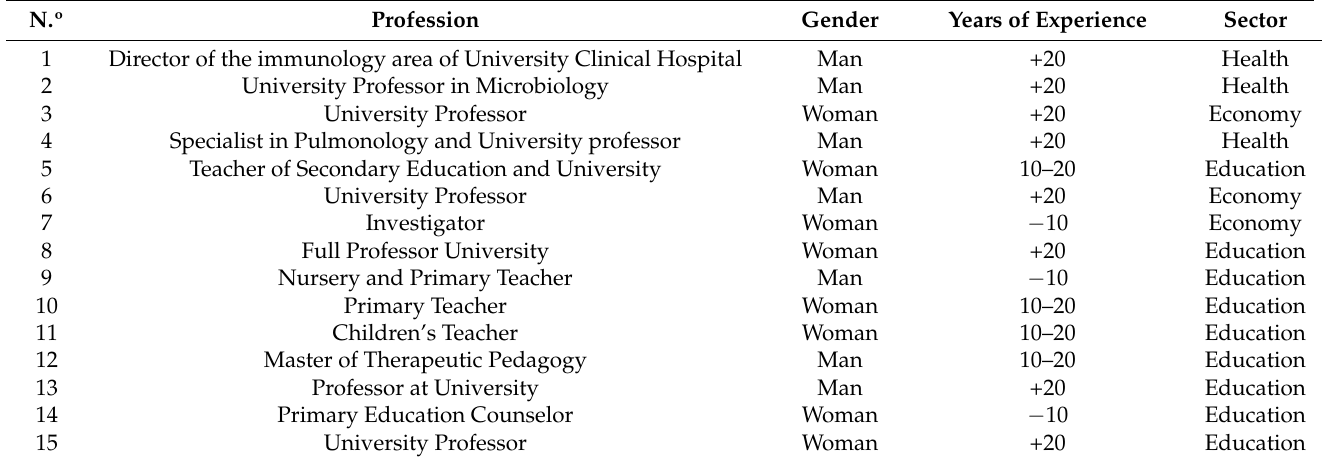
Table 1. Profession and gender of